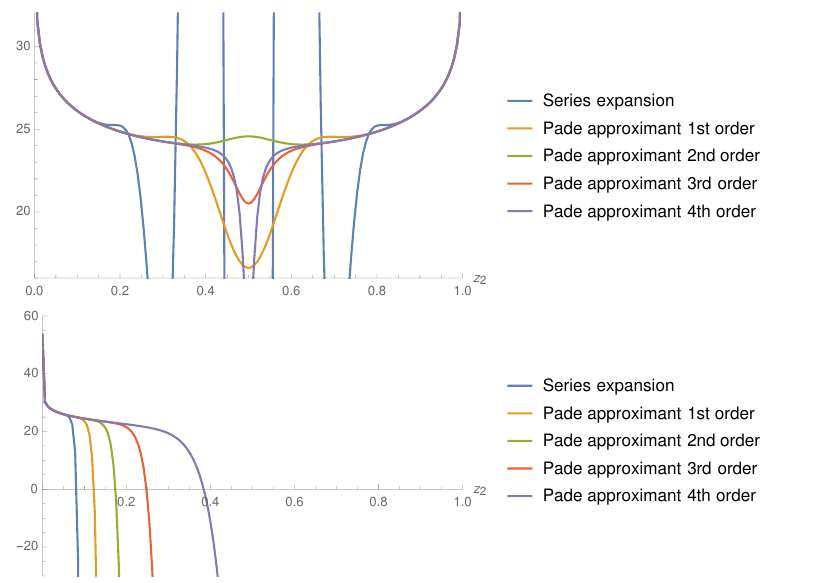
Figure 5 . Derivative of the Padé approximation of the semiclassical conformal block w.r.t. the internal conformal weight plotted against z . The upper plot shows the conformal block at β = 4 π 2 in the low temperature expansion and the lower plot the block at β = π in the high temperature expansion. For plotting convenience we set h = h which gives a derivative of f that is constant p q cl. for all h . As we increase the order of the denominator polynomial in the Padé approximation, the p fluctuations in f outside of the convergence radius of the series expansion decrease. Moreover, cl. multiple Padé approximants converge to the same value outside of the convergence radius. The convergence radius | y | = 1 is reached at z = 1 / 6 in the upper plot and z = log(2) = 0 . 0552 in 2 2 4 π the lower plot. The series expansion approximated by the Padé approximants in this figure was truncated at order 10 in both y and Q